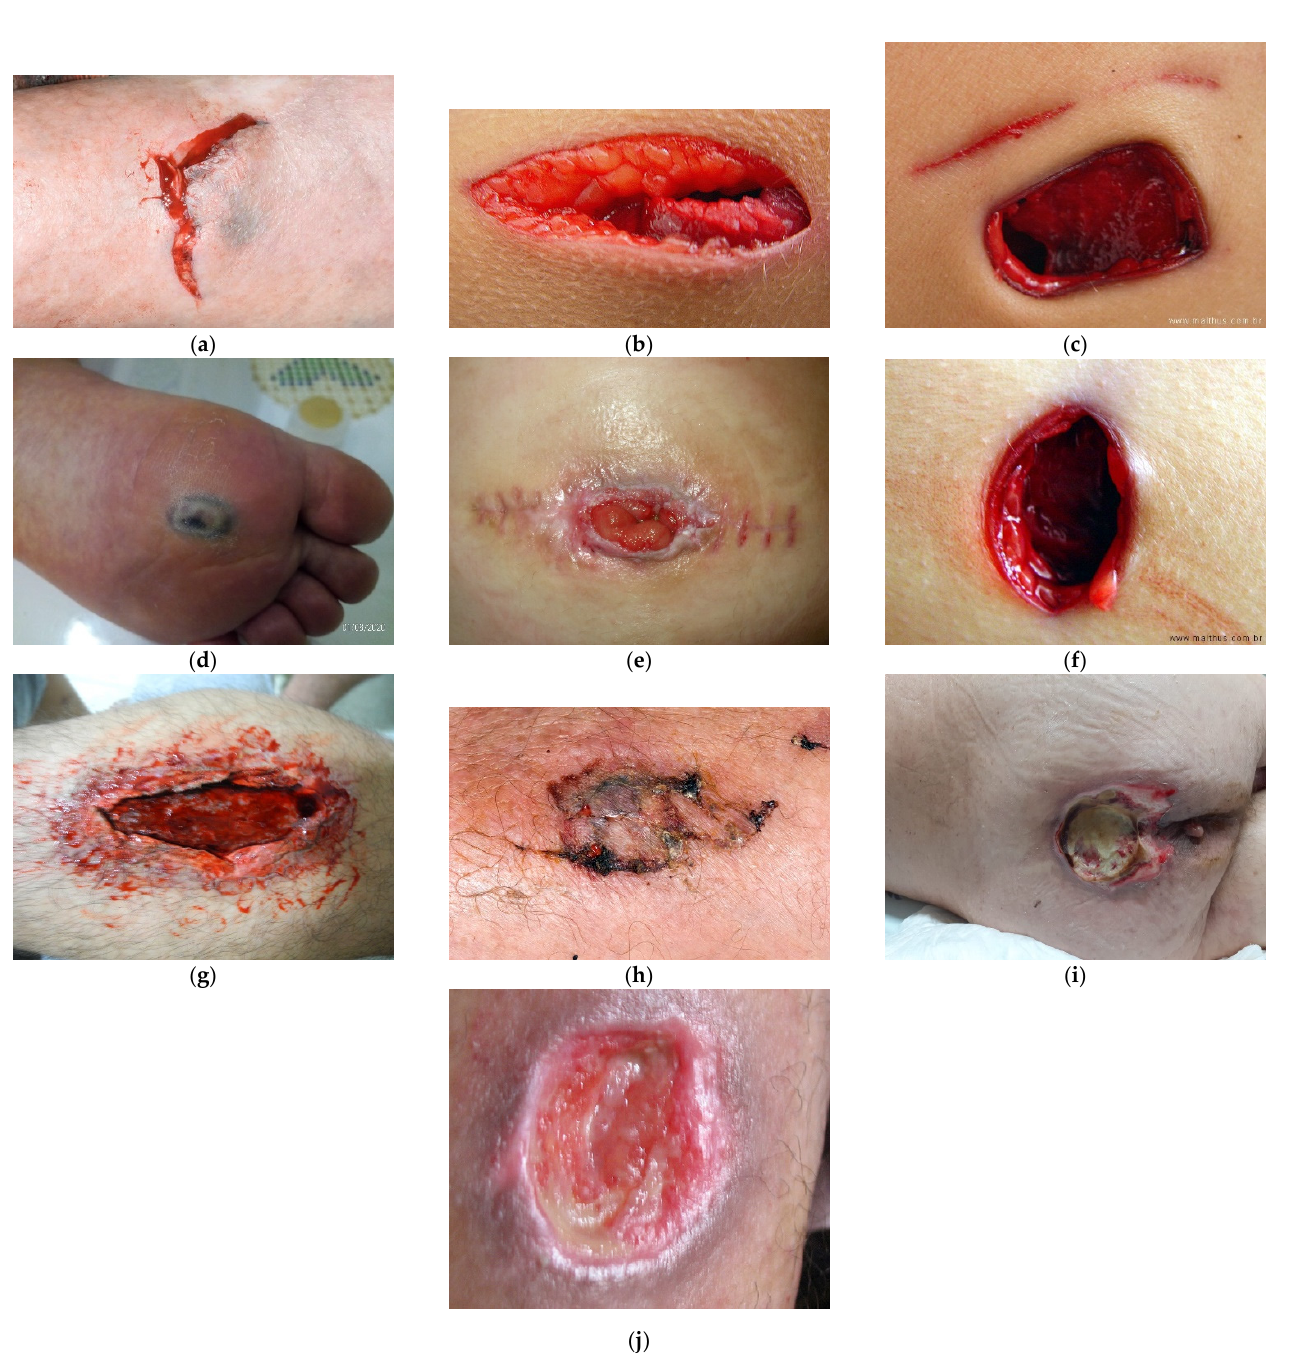
Figure 1. Example images of wounds. Figure ( a )—wound image in a human arm [44]; Figure ( b )—wound image in a human trunk; Figure ( c )— wound image in a human trunk; Figure ( d )—wound image in a human foot; Figure ( e )— wound image in a human trunk [45]; Figure ( f )— wound image in a human trunk [45]; Figure ( g )—wound image in a human arm [45]; Figure ( h )—wound image in a human arm [45]; Figure ( i )—wound image in a human tail; Figure ( j )—wound image in a human leg [44].